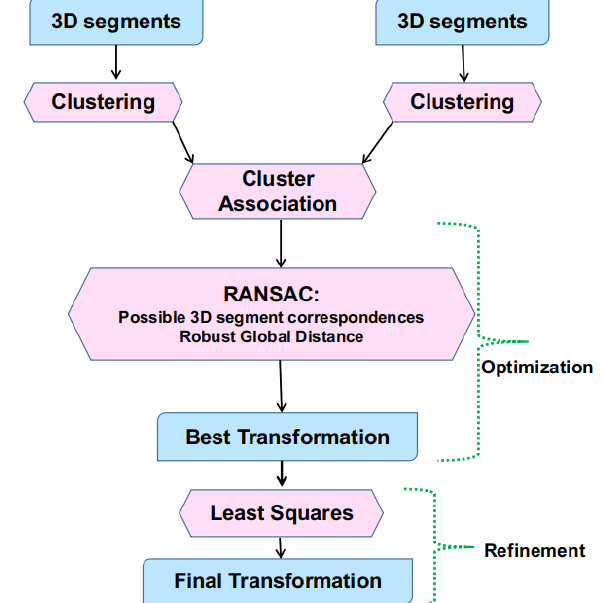
Figure 1. Pipeline